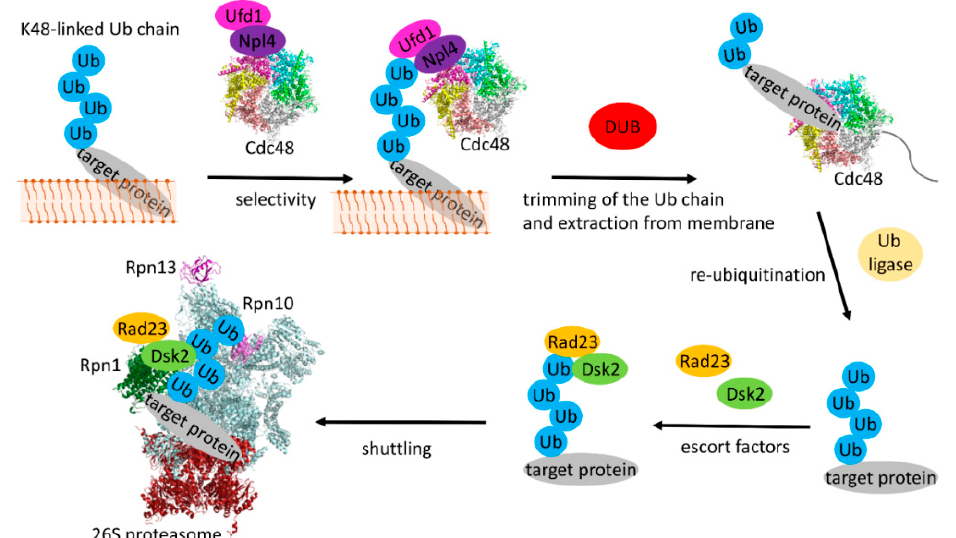
Figure 5. Cartoon showing the main components involved in target protein extraction and ubiquitin chain processing. For clarity, all components of the Hrd1 or Doa10 complexes are omitted. The AAA+ ATPase Cdc48 (PDB ID: 6OPC) with its two associated factors Ufd1 and Npl4 interacts with the ubiquitin chain of the target protein which leads to its extraction from the membrane. The ubiquitin chain gets processed first by trimming to an oligo-chain. After translocation through the central pore of Cdc48 the chain is again elongated, then bound to the escort factors Rad23 and Dsk2 and recruited to the proteasome for final degradation. Interaction with the proteasome is initiated by binding of the escort factors to Rpn1 and of the ubiquitin chain to Rpn10 and Rpn13 on the lid structure of the proteasome (PDB ID: 4CR2).